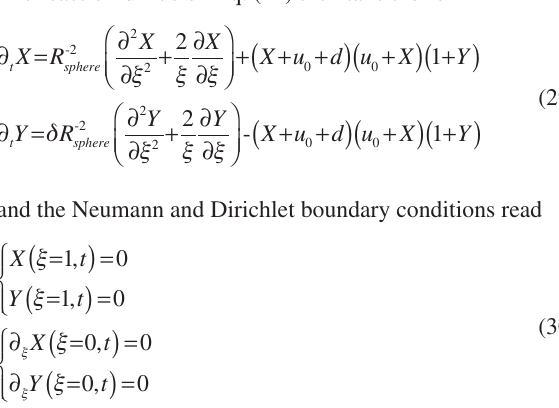
= 4.38 × 10 -3 M , k = 4.5 × 10 3 M -3 s -1 k a 20 = 0.0372 cm and R inf